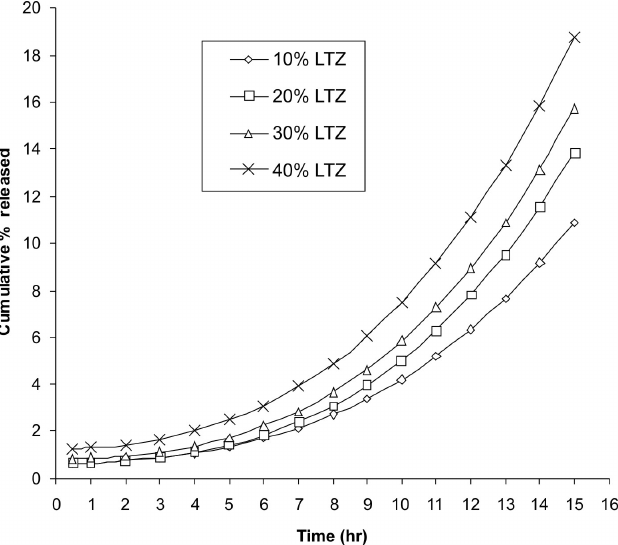
FIGURE 5 - In vitro release data of LTZ –PLGA-NPs (n=3, Std. Deviation not